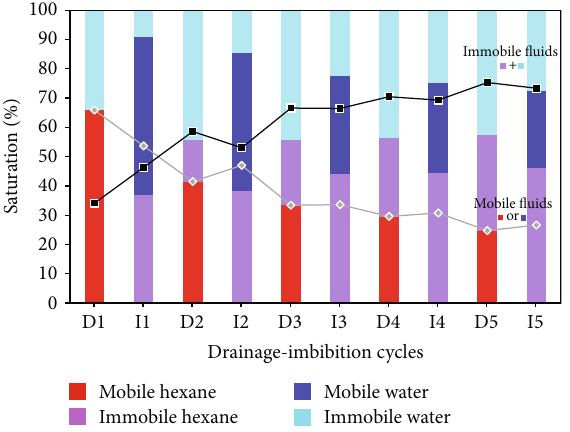
Figure 10: Saturation of mobile and immobile fl uids over the course of fi ve sets of drainage-imbibition